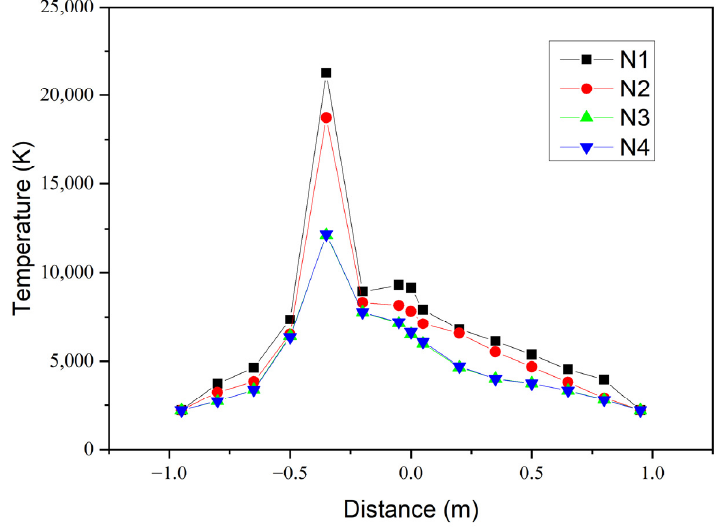
Figure 4. Grid independence verification results.